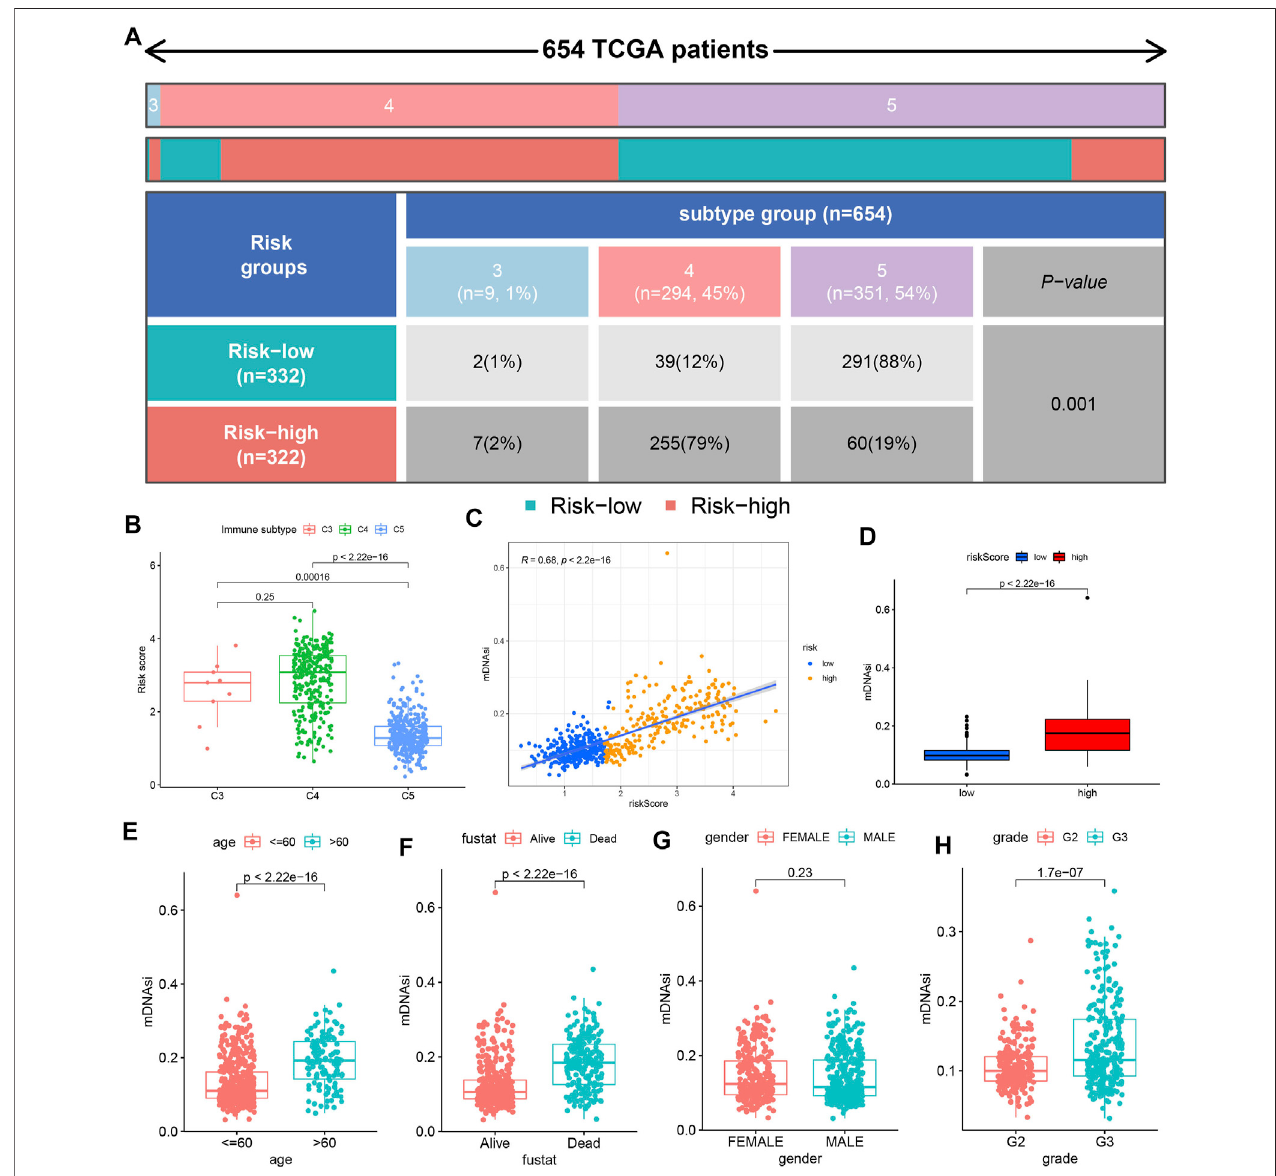
FIGURE 8 | Immune in fi ltration type and cell stemness analyses. (A) Table showing the distribution of immune in fi ltrating subtypes (C3, C4, and C5) between the different risk groups. (B) Risk score difference among the 3 immune in fi ltrating subtypes. (C) Correlation analysis results between mDNAsi and risk score. (D) Difference analysis results of mDNAsi between high-risk and low-risk groups. (E – H) Difference analysis results of mDNAsi between different clinical feature subgroups.